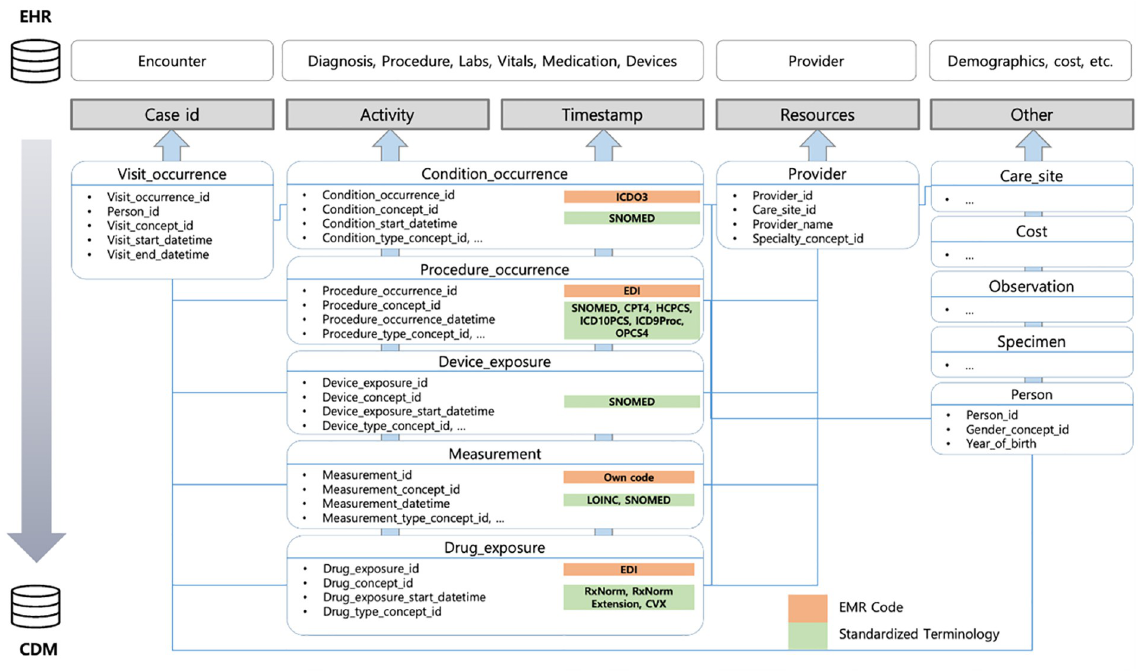
Fig 2. Relevant CDM tables for event log construction. Code names are sourced from